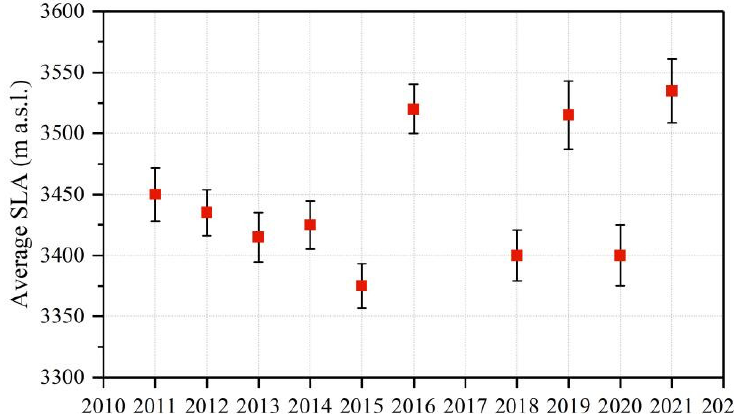
Figure 6. The average snowline altitude of the Muz Taw Glacier in the Sawir Mountains derived from Landsat over the period during 2011–2021.